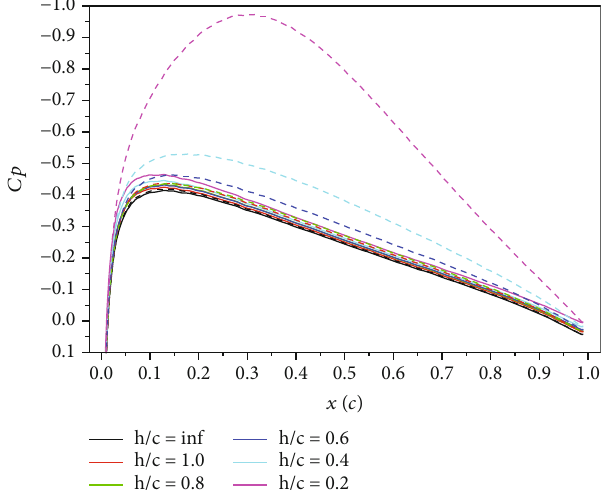
Figure 10: Pressure coe ffi cient of the CC airfoil without blowing at α = 0 °